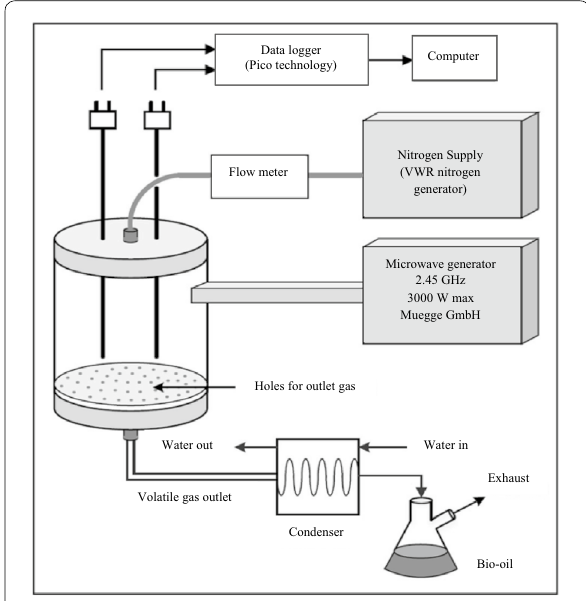
Fig. 1 Schematic showing microwave reactor integrated with data recording unit